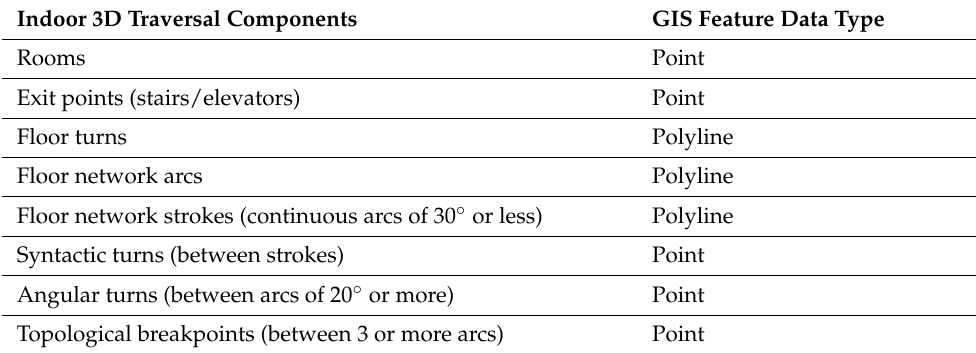
Figure 14. Accessibility estimation workflow. Table 2. GIS feature classes in the data